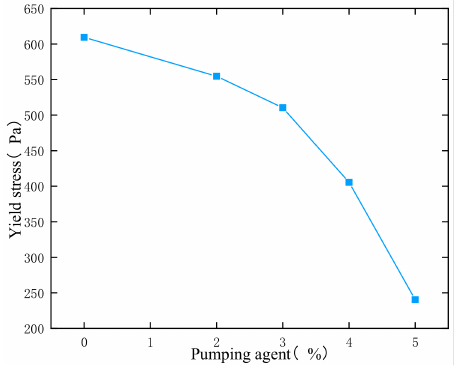
Figure 6. Yield stress curve for different pumping agent dosages.